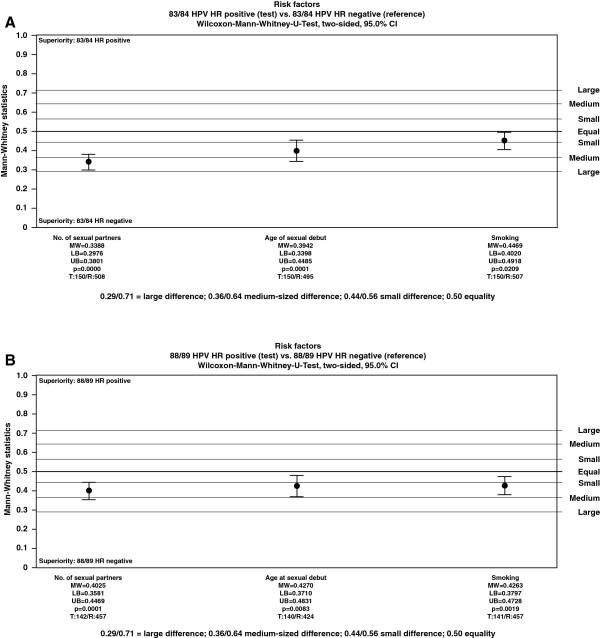
Univariate analysis of risk factors for HR-HPV infection in (A) in 1983/84 cohort and (B) 1988/89 cohort. In this analysis, the Mann Witney measure (0.0 to 1.0) reflects the probability that a randomly selected patient from the test group is better off than a randomly selected patient from the control group. Benchmark values are: 0.36 medium-sized inferiority, 0.44 small inferiority, 0.50 equality, 0.56 small superiority, 0.64 medium-sized (relevant) superiority, and 0.71 large superiority. For non-inferiority the benchmark is defined as MW-measure = 0.36 (medium-sized inferiority), for superiority the benchmark is defined as MW-measure = 0.50 (equality). The medium-sized superiority (inferiority) is – per definition – a medically relevant group-difference [18].